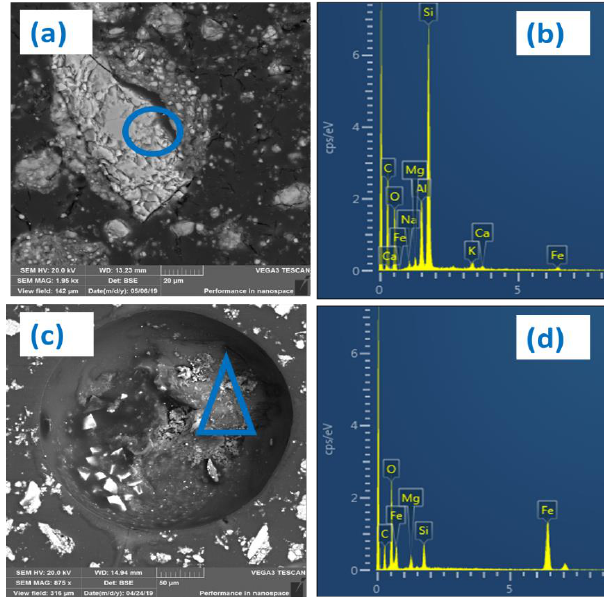
Figure 8. SEM–EDS of zeolite before and after the reaction with acid mine drainage: ( a ) micrograph of unreacted zeolite, ( b ) EDS spectra taken at a point selected with a circle in ( a ), ( c ) micrograph of reacted zeolite, ( d ) EDS spectra taken at a point selected with a triangle in ( c ).